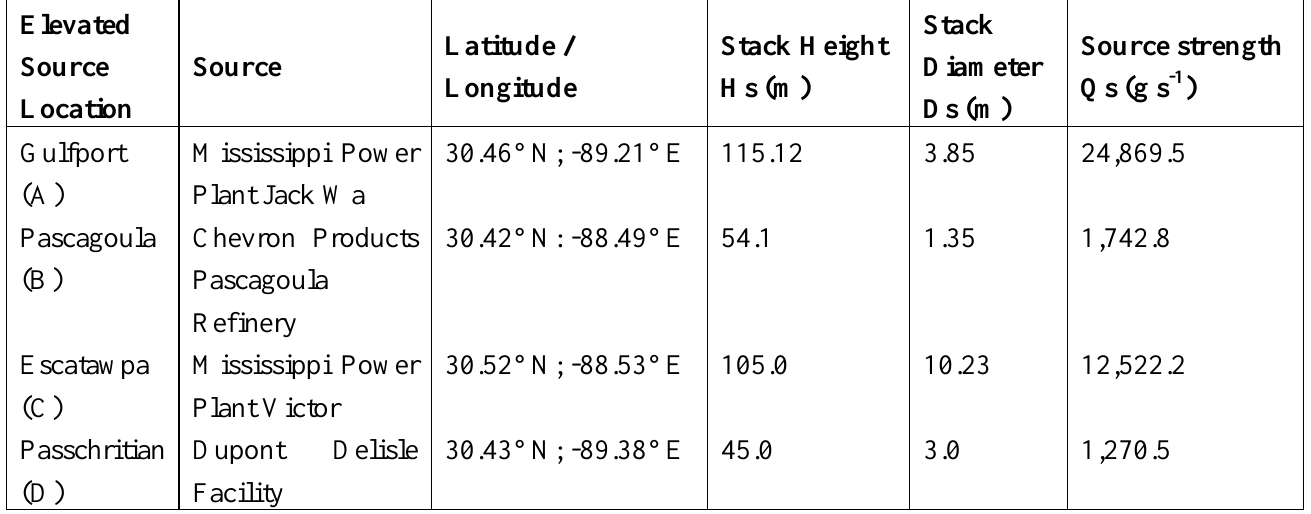
Table 2. Sources of elevated release considered for the HYSPLIT computations.